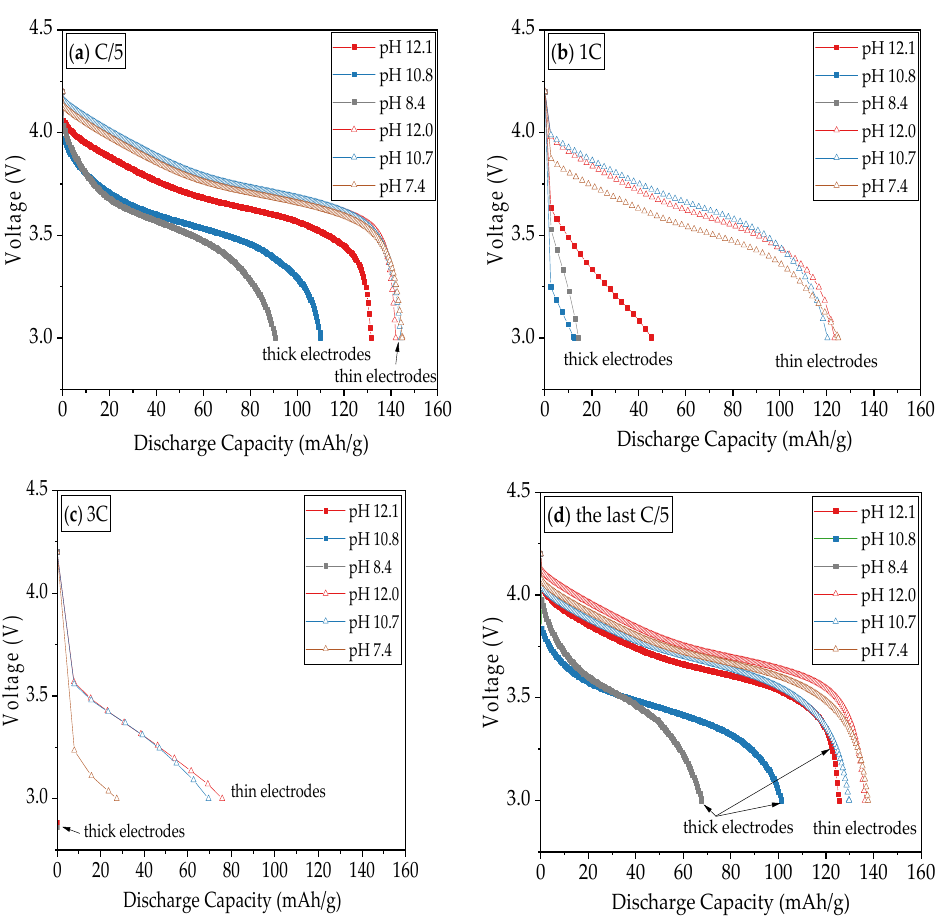
Figure 11. Comparison of the discharge capacity of cells containing thin-film and thick-film cathodes produced with slurry pH values 12, 11, and 8 from Figure 6 at discharge rates of ( a ) C/5, ( b ) 1C, ( c ) 3C, and ( d ) the last C/5.